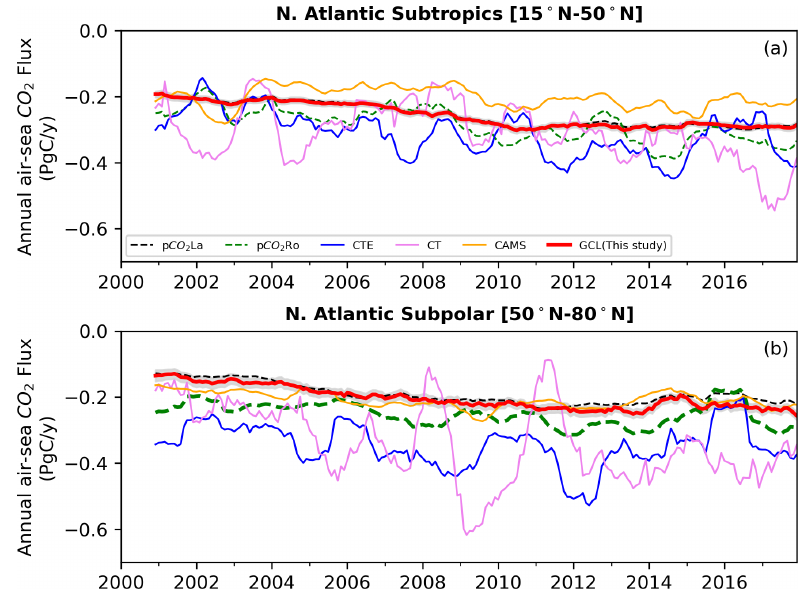
Figure 2. Comparison of annual air–sea CO 2 fluxes for North Atlantic for the 2000–2017 period for (a) North Atlantic subtropics and (b) North Atlantic subpolar regions. The GCL posterior flux estimate from this study (red) is derived from the prior flux of Landschützer et al. (2016) ( p CO 2 La, black). The shaded grey area represents the uncertainty estimate on the GCL posterior flux (plotted at a 1 σ level). Also shown are the flux estimates of (i) Chevallier et al. (2019) (CAMS, yellow), (ii) Jacobson et al. (2020) (CT, CarbonTracker 2019, pink), and (iii) van der Laan-Luijkx et al. (2017) (CTE, Carbon Tracker Europe, blue). All time series shown have a 12-month running mean filter